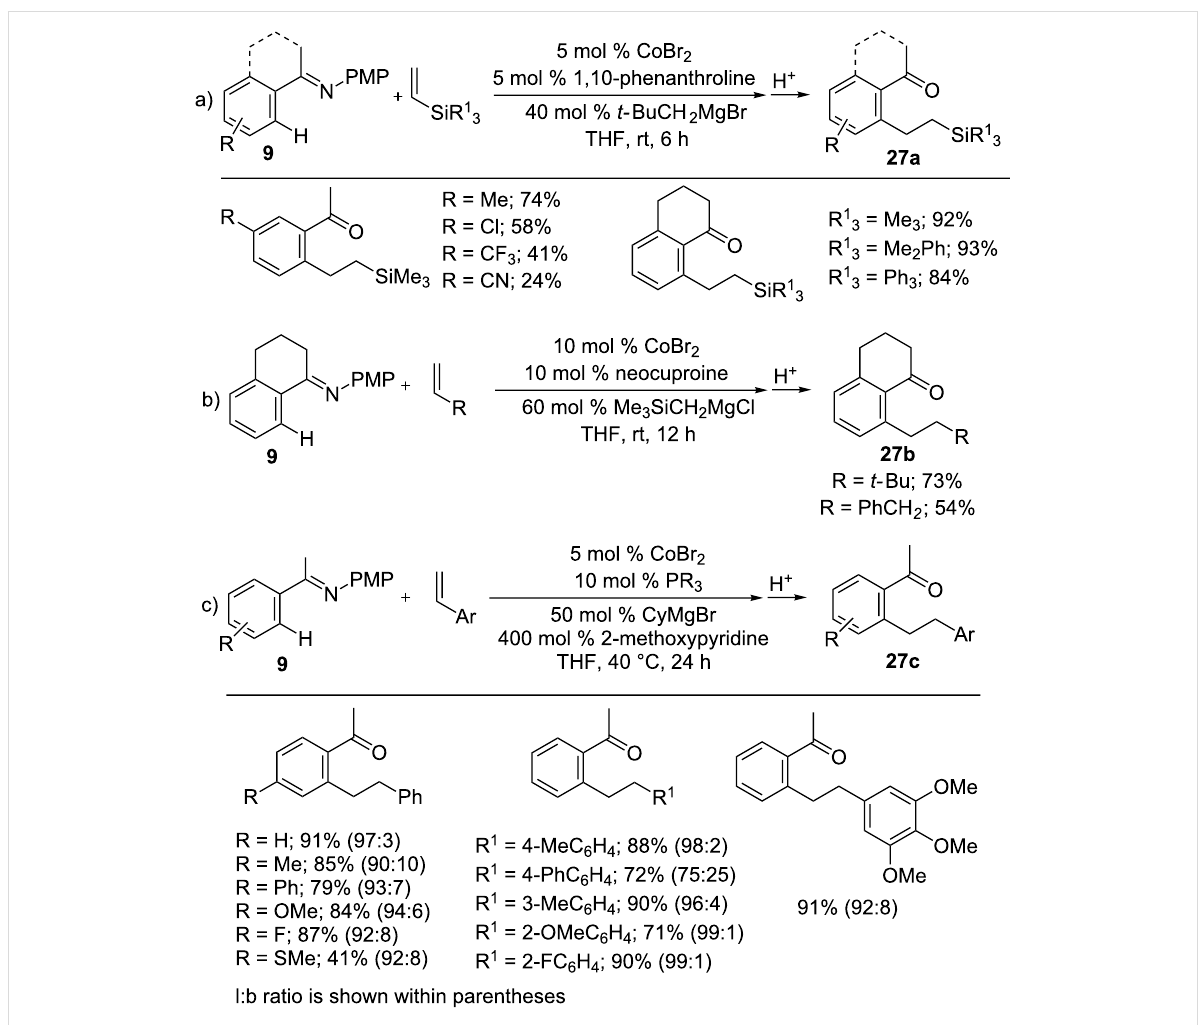
Scheme 18: Co-catalyzed linear-selective hydroarylation of alkenes with